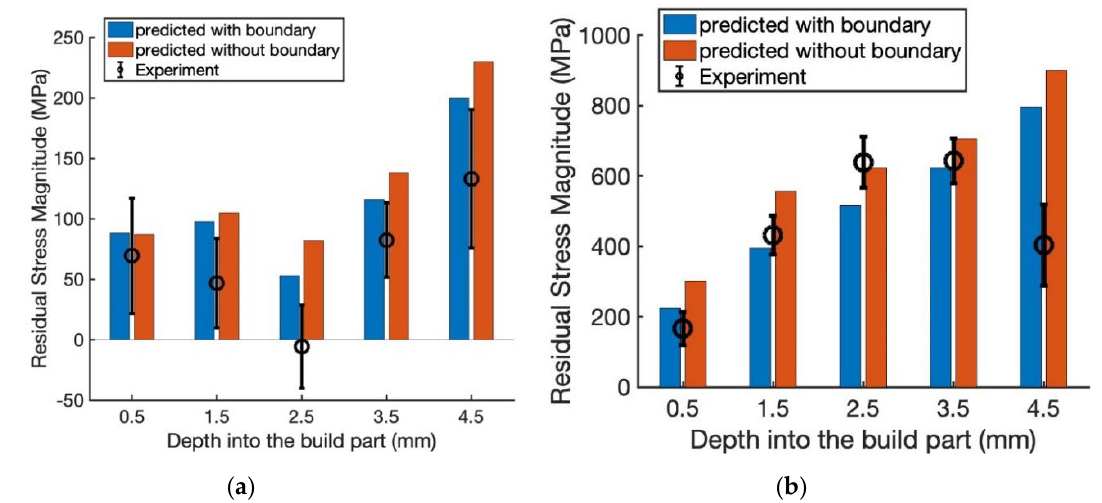
Figure 8. Predicted and measured residual stress of IN718 sample built via L-PBF with the laser power of 250 W and scan speed of 600 mm/s, layer thickness of 30 µ m, and hatching space of 100 µ m: ( a ) along the scan direction; and ( b ) along the build direction.